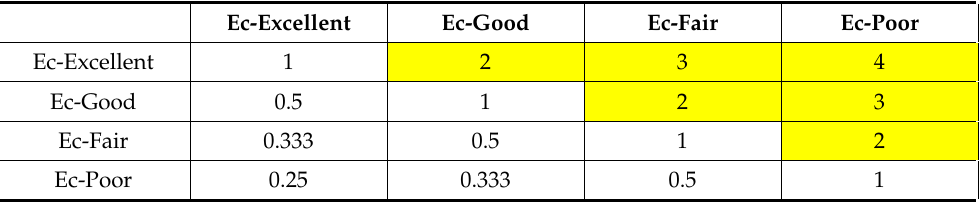
Table 14. Pairwise Comparisons for the Economy Criterion.